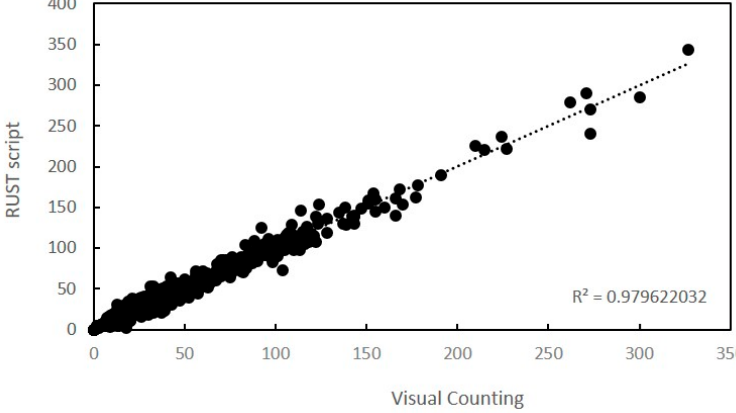
Figure 4. Linear relationship between the number of pustules estimated visually or with RUST.